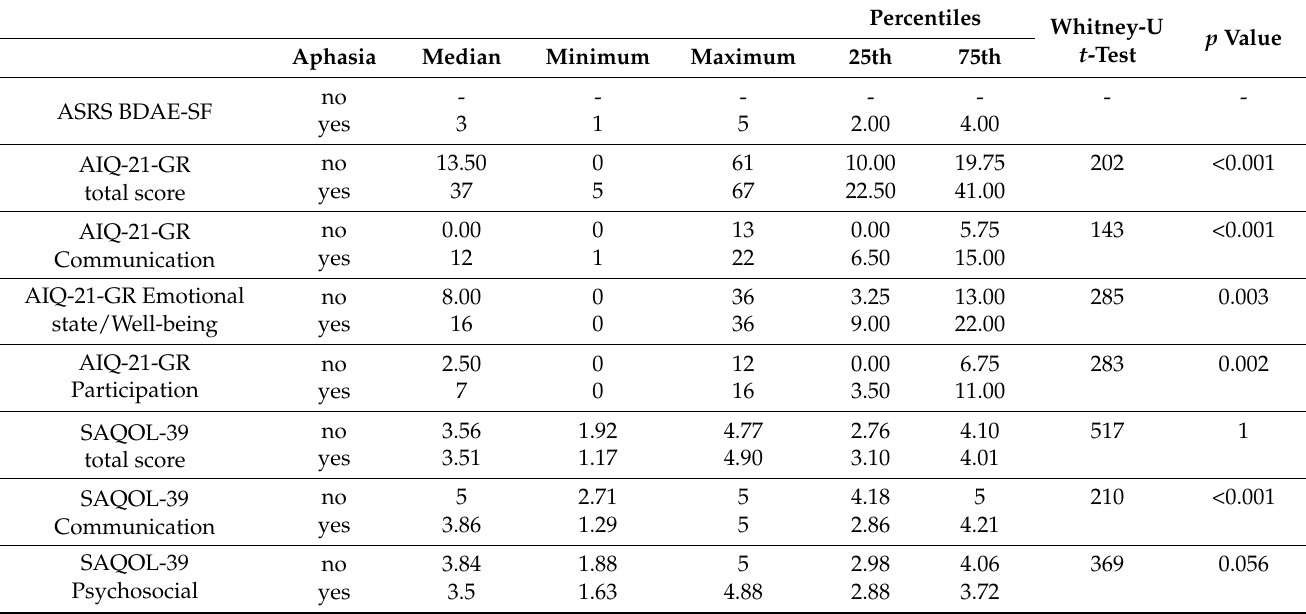
Table 3. Scores in Aphasia Severity Rating Scale (ASRS), AIQ-21-GR, and SAQOL -39 for PWA and stroke survivors without aphasia.